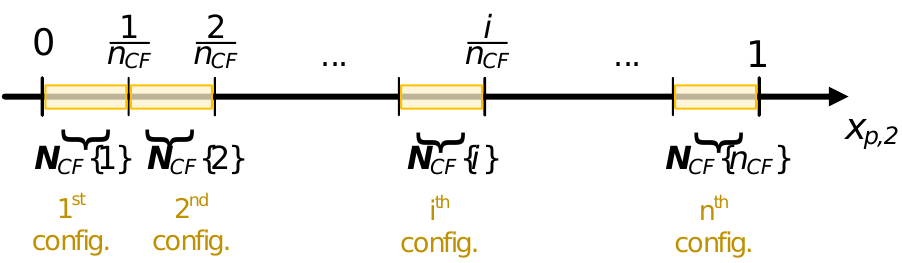
Figure 3. Discretization of a search